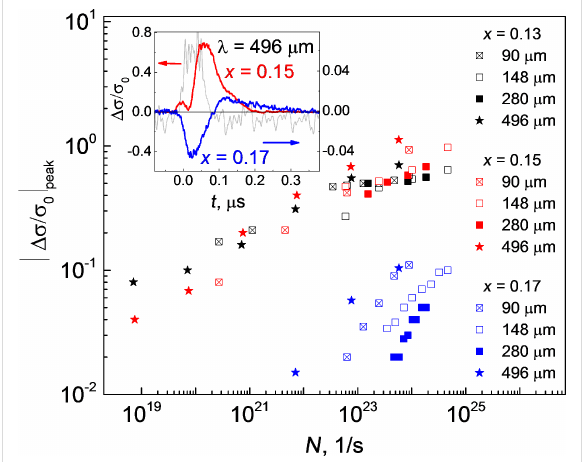
Figure 2: Dependence of the absolute value of the peak photore- sponse amplitude | Δσ / σ 0 | peak ( σ 0 is the conductivity before a laser pulse, Δσ is the conductivity change under illumination) on the photon flux density N for Hg 1 − x Cd x Te films with x = 0.13 (black symbols), x = 0.15 (red symbols), and x = 0.17 (blue symbols) at various wave- lengths. The photoconductivity kinetics at 496 µm for the samples with x = 0.15 and x = 0.17 are shown in the inset. A typical pulse time profile is shown by the grey